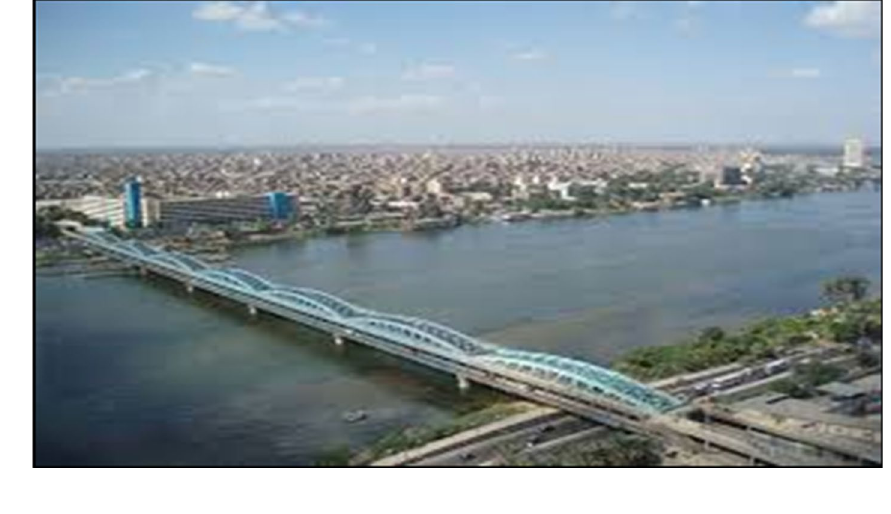
Table 3 Field data of local scour depth at Imbaba Bridge, Egypt (HRI 1992)